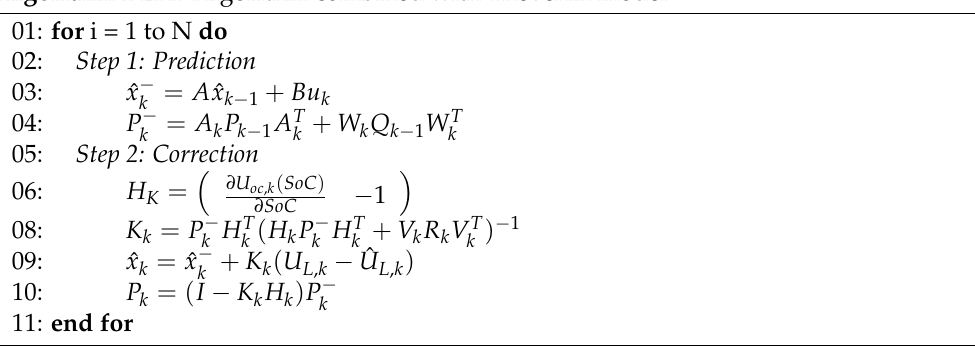
Algorithm 1 EKF Algorithm combined with Thevenin